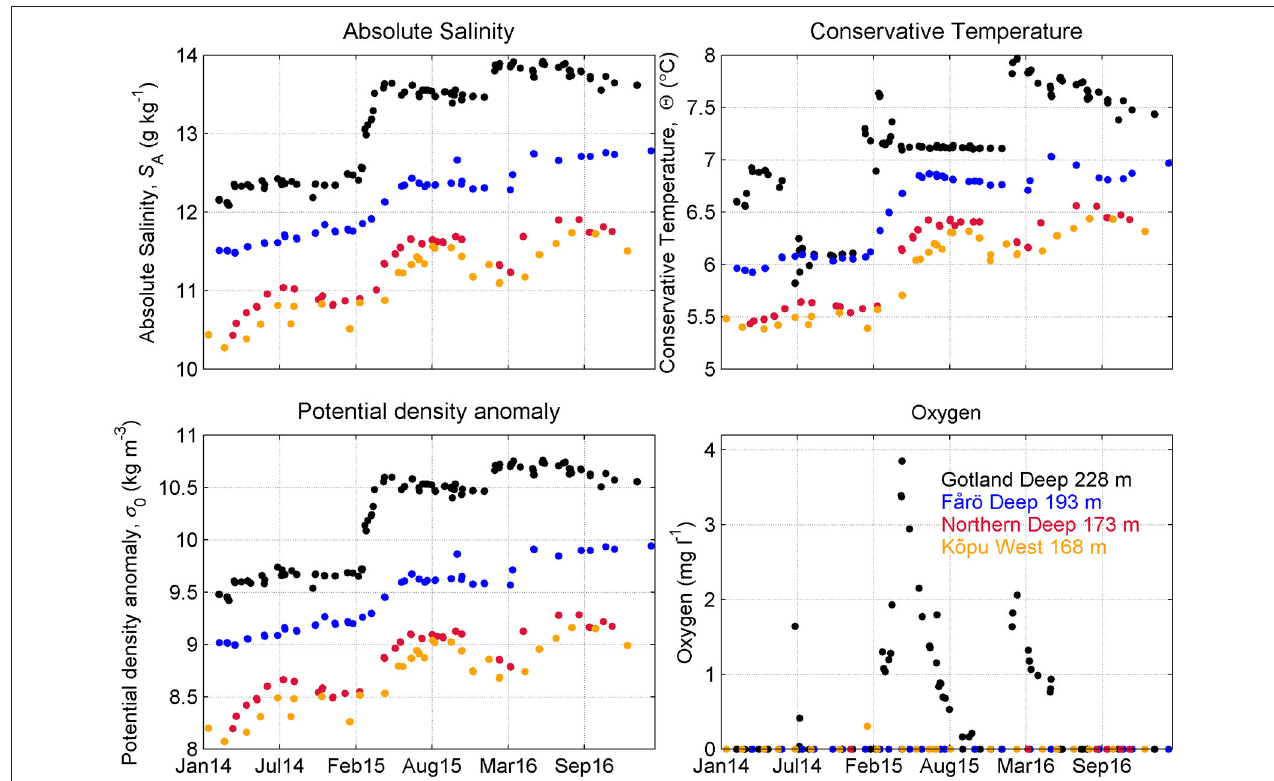
FIGURE 6 | Time series of temperature, salinity, potential density anomaly and oxygen concentration in the near-bottom layers of the Gotland Deep, Fårö Deep, Northern Deep and Kõpu West. The daily mean was calculated when there was more than one CTD cast. The depths was chosen according to the amount of available data. It means, in some cases occasional deeper measurements might show slightly higher values. For example, the highest salinity during the study period, 14.1g kg − 1 was observed in the Gotland Deep at 235m depth on 16 February